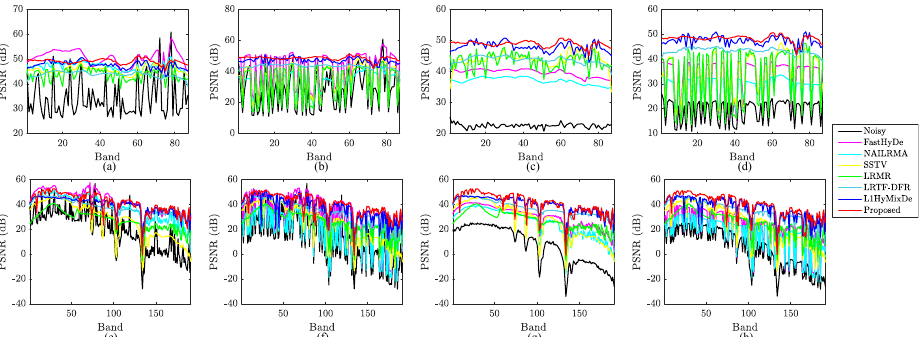
Figure 5. Band-wise PSNR values for denoised Pavia University data in the first row and for denoised Washington DC Mall data in the second row. Subfigures in ( a , e ), ( b , f ), ( c , g ), ( d , h ) corresponds to case 1, case 2, case 3, and case 4, respectively.